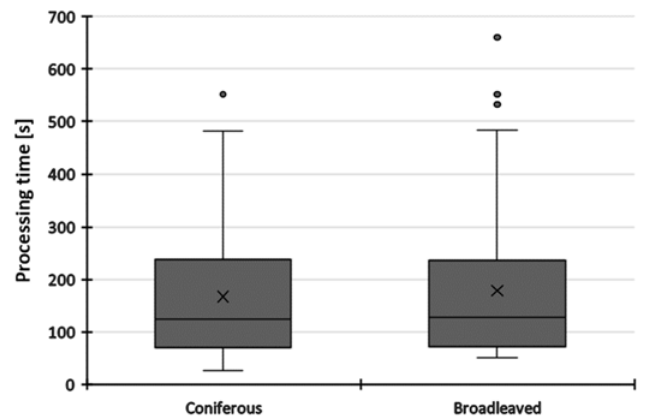
Figure 7. Comparison of time for processing one stump by tree species type (coniferous, broad ‐ leaved).